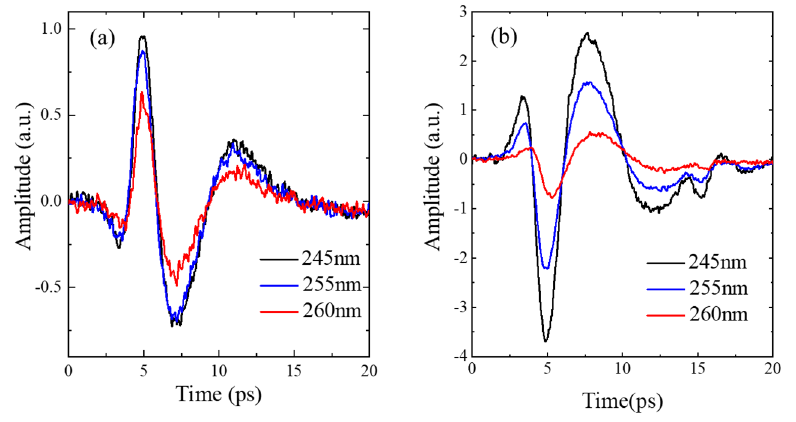
Figure 4. THz emission waveforms of ( a ) #UID-1 and ( b ) #FeD at various wavelengths.